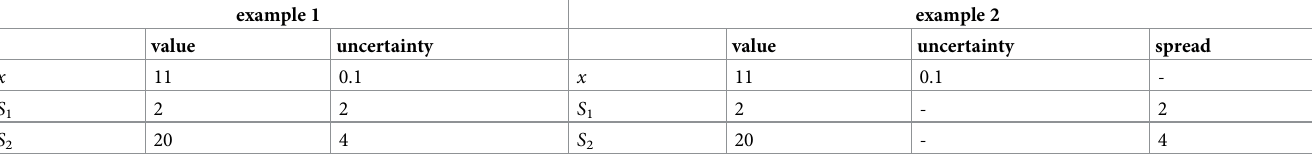
Table 1. Input values used for the calculations of 1D examples. See the text for details.